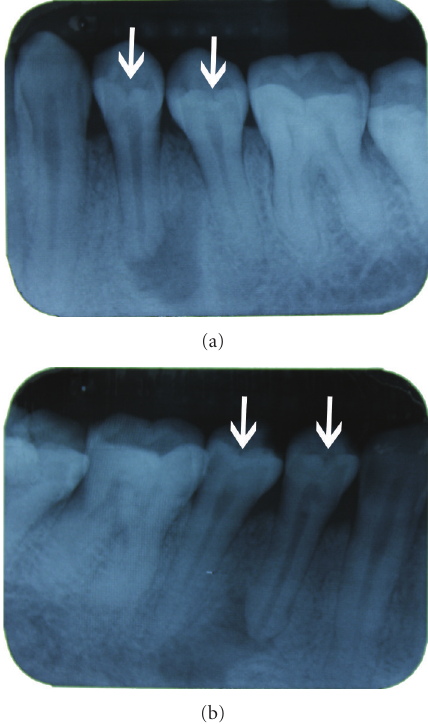
Figure 1: Long-cone periapical radiographs showing the left 1(a) and right 1(b) mandibular premolars. Well-demarcated periapical radiolucencies can be seen associated with the first premolar teeth bilaterally. The white arrows indicate radiolucent “invaginations” on the occlusal surfaces of the